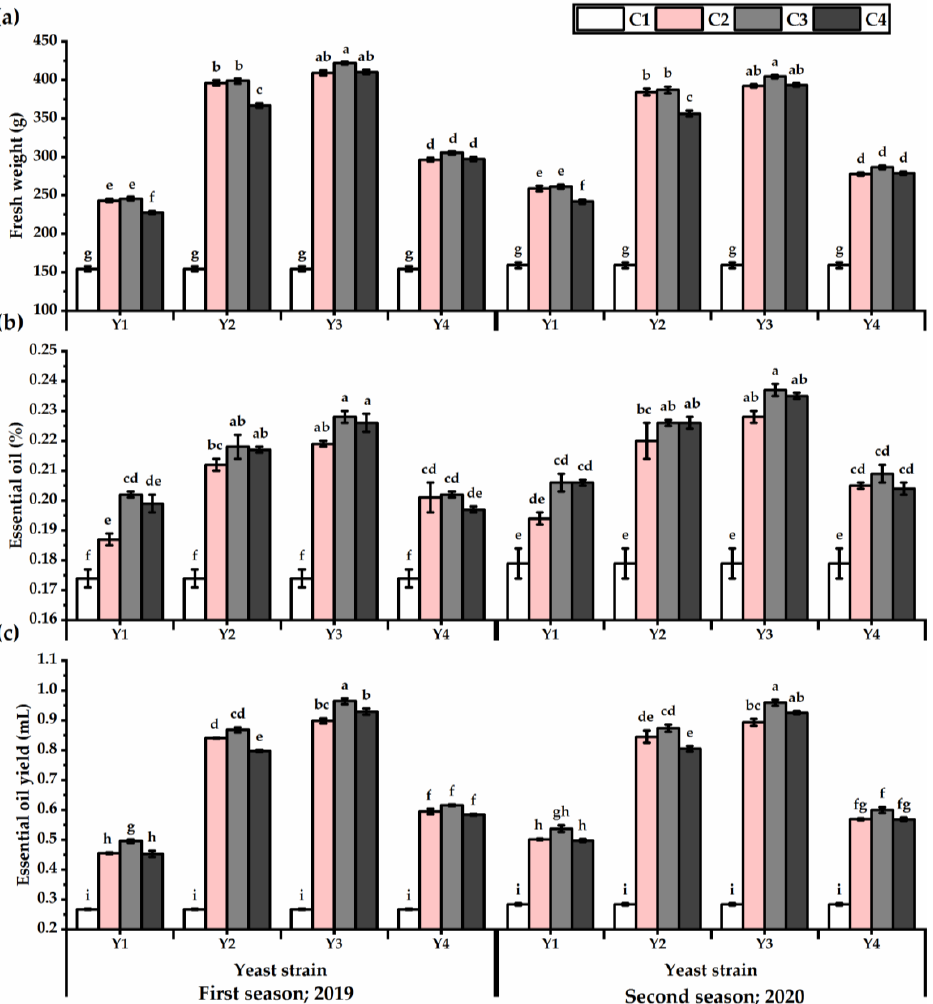
Figure 3. Fresh weight (g) ( a ), essential oil (%) ( b ), and essential oil yield (mL) ( c ) of Plectranthus amboinicus (Lour.) Spreng. plants subjected to Rhodotorula muciligenese (Y1), Candida sake (Y2), Candida apicola (Y3), and Candida kunwiensis (Y4) yeast strains foliar application at 0 (C1), 1 × 10 4 (C2), 1 × 10 7 (C3), and 1 × 10 9 (C4) CFU mL –1 concentrations during 2019 and 2020 seasons. Data are mean value ± SE. Means with different letters for each season significantly differed, using Tukey’s test at p ≤ 0.05 level, n =